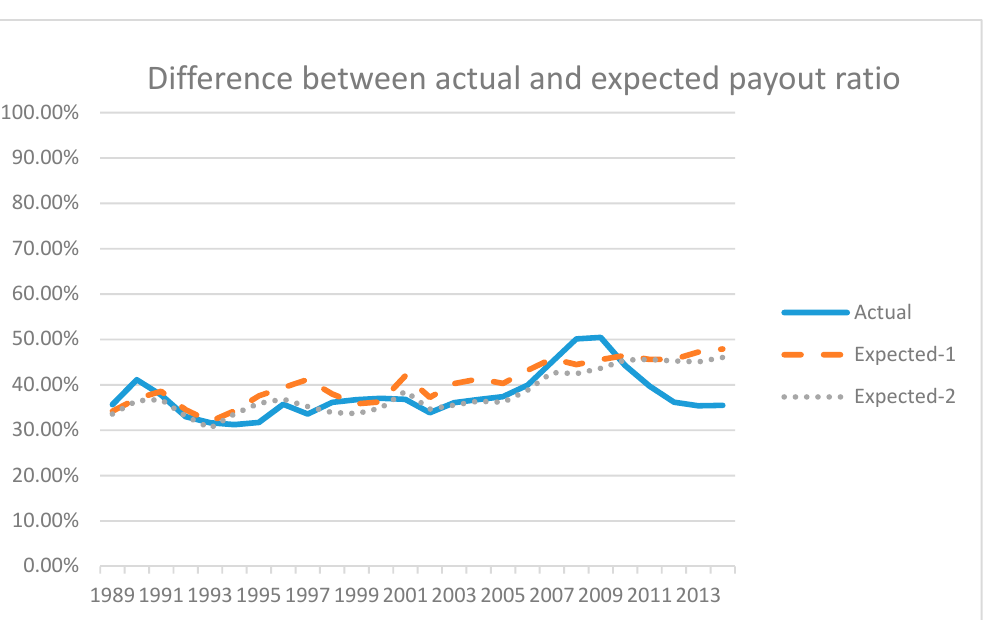
Figure 2. Difference between the actual and expected payout ratios.